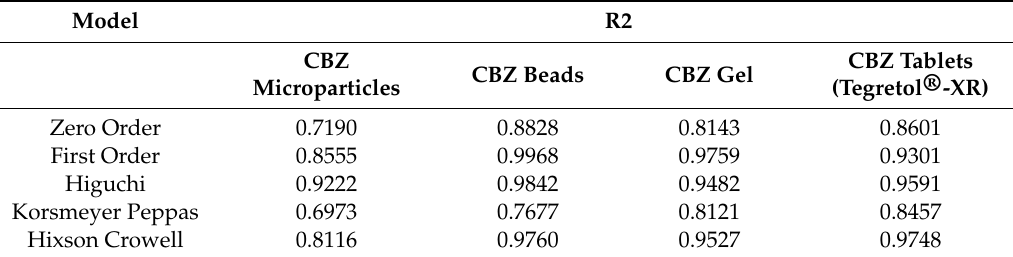
Table 2. Fitting of the release profiles into di ff erent kinetic models.